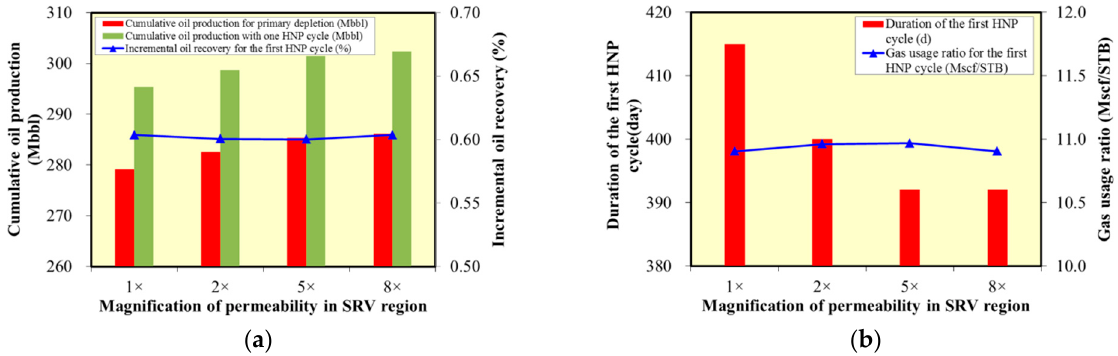
Figure 25. Correlation between magnification of permeability in SRV region and huff-n-puff results: ( a ) Cumulative oil production and incremental oil recovery for different magnification of permeability in SRV region; ( b ) Duration of the first huff-n-puff cycle and gas usage ratio for different magnification of permeability in SRV region.